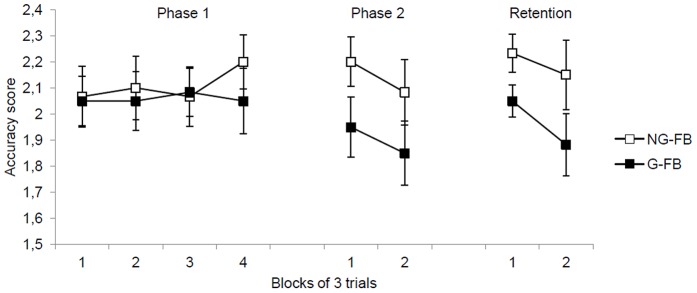
Accuracy scores during phase one, phase two, and retention for the G-FB and NG-FB groups.Error bars indicate standard errors.